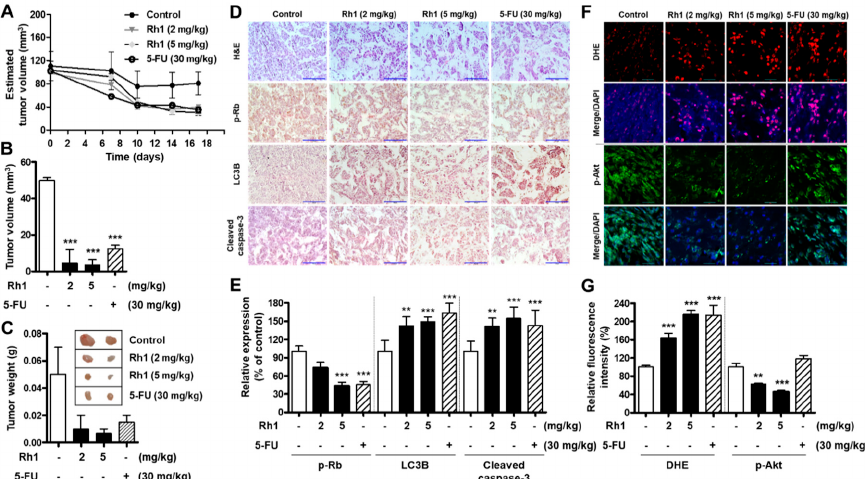
Figure 6. Rh1 showed a competitive effect with an estrogenic agent on BC cells. ( A ) MCF-7 cells and HCC1428 cells were treated with different concentrations of Rh1 (5, 25, and 50 µM) for 24 h. Total cell lysates then analyzed the estrogen receptor alpha (Er α ) protein expression using Western blotting. ( B , C ) MCF-7 cells and HCC1428 cells were treated with 10-nM DES in the presence or absence of Rh1 (5, 25, and 50 µM) or 10-µM 4-OHT for 30 min. Total cell lysates were then analyzed using Western blotting ( B ). The relative quantification of protein levels ( C ) was analyzed using Image J software. ( D , E ) MCF-7 cells ( D ) and HCC1428 cells ( E ) were treated with 10-nM DES in the presence or absence of Rh1 (5, 25, and 50 µM) or 10-µM 4-OHT for 24 h. The 3-(4, 5-dimethylthiazole-2-yl)-2, 5-diphenyltetrazolium bromide (MTT) assay was used to analyze the cell viability. ( F ) MCF-7 cells and HCC1428 cells were treated with 10-nM DES in the presence or absence of Rh1 (5, 25, and 50 µM) or 10-µM 4-OHT for 12 h. Total cell lysates were then analyzed using Western blotting. ( C – E ) Data are presented as the mean ± SD ( n = 3 ), * p < 0.05 and * * p < 0.01 compared with the control sample and # p < 0.05, ## p < 0.01 and ### p < 0.001 compared with the DES-treated sample, respectively. 4-OHT: 4-hydroxytamoxifen and DES: diethylstilbestrol.